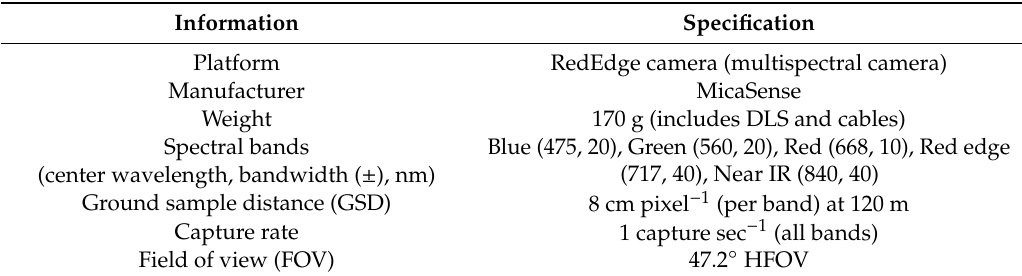
Table 3. Multispectral camera (RedEdge camera)